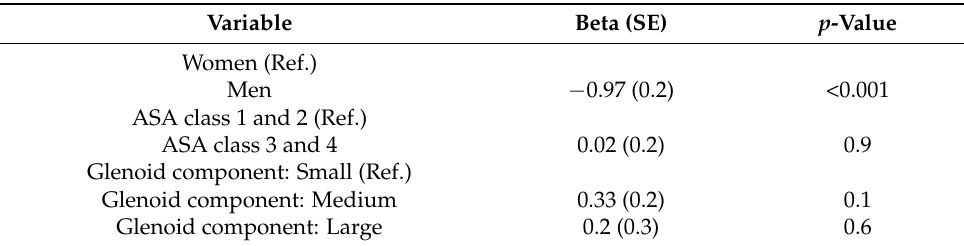
Table 5. Association between gender, ASA class, glenoid component size, and the Franklin radiolu- cency grade (dependent variable). Variable Beta (SE) p -Value Women (Ref.) Men − 0.97 (0.2) <0.001 ASA class 1 and 2 (Ref.) ASA class 3 and 4 0.02 (0.2) 0.9 Glenoid component: Small (Ref.) Glenoid component: Medium 0.33 (0.2) 0.1 0.2